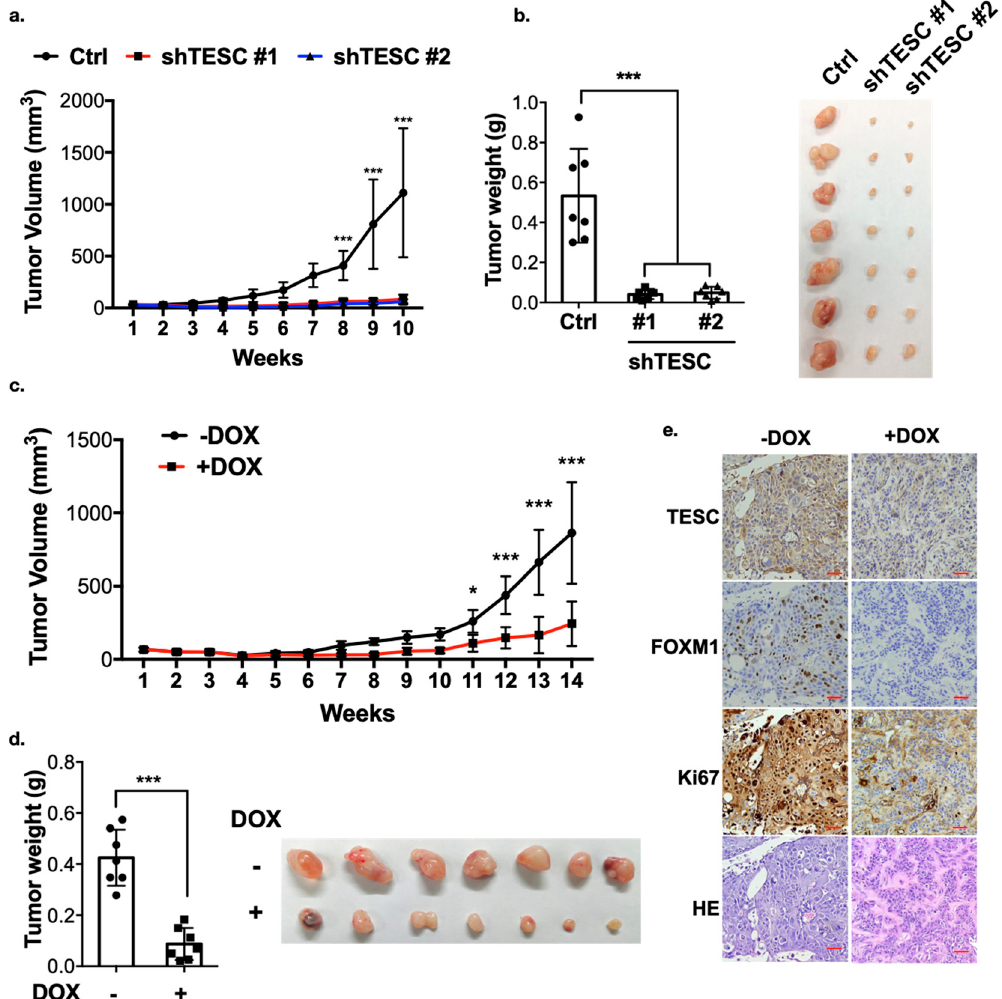
Figure 7. TESC regulates cholangiocarcinoma growth in vivo. ( a ) TESC-silenced HUCCT1 cells were injected subcutaneously into the flank region of nude mice, and tumor volume was monitored. Error bars indicate standard error of the mean (SEM); n = 7; *** p < 0.001. ( b ) Tumors from ( a ) were weighed (left) and photographed (right) 10 weeks after injection. Error bars indicate SEM; n = 7; *** p < 0.001. ( c ) HUCCT1-tet_on-shTESC cells were injected subcutaneously into the flank region of nude mice. Two weeks after injection, mice were treated with or without doxycycline (DOX, 1 mg / mL in drinking water). Tumor volumes were monitored over time as indicated. Error bars indicate SEM; n = 7; * p < 0.05, *** p < 0.001. ( d) Tumors from ( c ) were weighed (left) and photographed (right) 14 weeks after injection. Error bars indicate SEM; n = 7; *** p < 0.001. ( e ) Excised tumors from mice in ( d ) were further subjected to hematoxylin and eosin (H&E) staining combined with immunohistochemistry analysis. Red scale bar, 50 µ